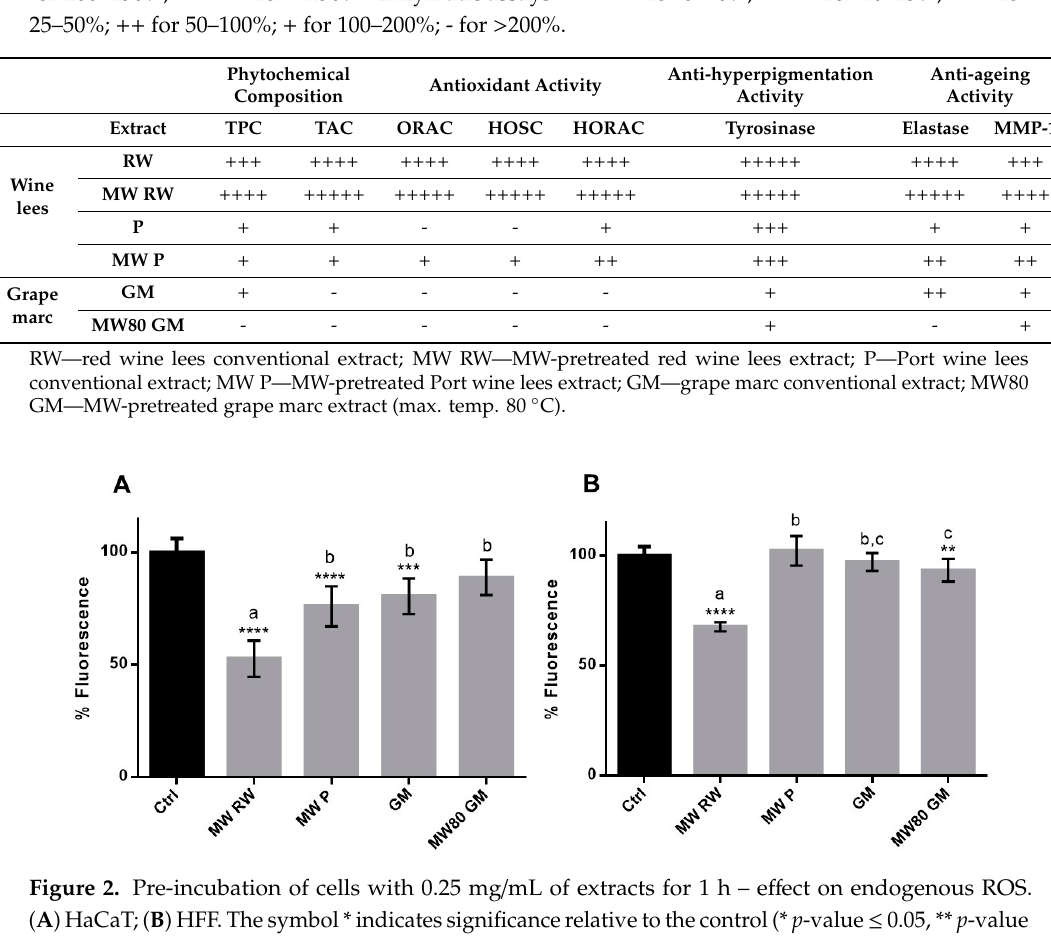
Table 4. Summary of the results obtained by the extracts in chemical and enzymatic assays, in terms of phytochemical composition, antioxidant, anti-hyperpigmentation and anti-ageing activities. For each assay, the extracts were rated based on their percentage relative to the mean. Phytochemical composition and antioxidant activity: - for 0–50%; + for 50–100%; ++ for 100–150%; +++ for 150–200%; ++++ for 200–250%; +++++ for > 250%. Enzymatic assays: +++++ for 0–10%; ++++ for 10–25%; +++ for 25–50%; ++ for 50–100%; + for 100–200%; - for > 200%. Anti-hyperpigmentation Phytochemical Antioxidant Activity Composition Activity